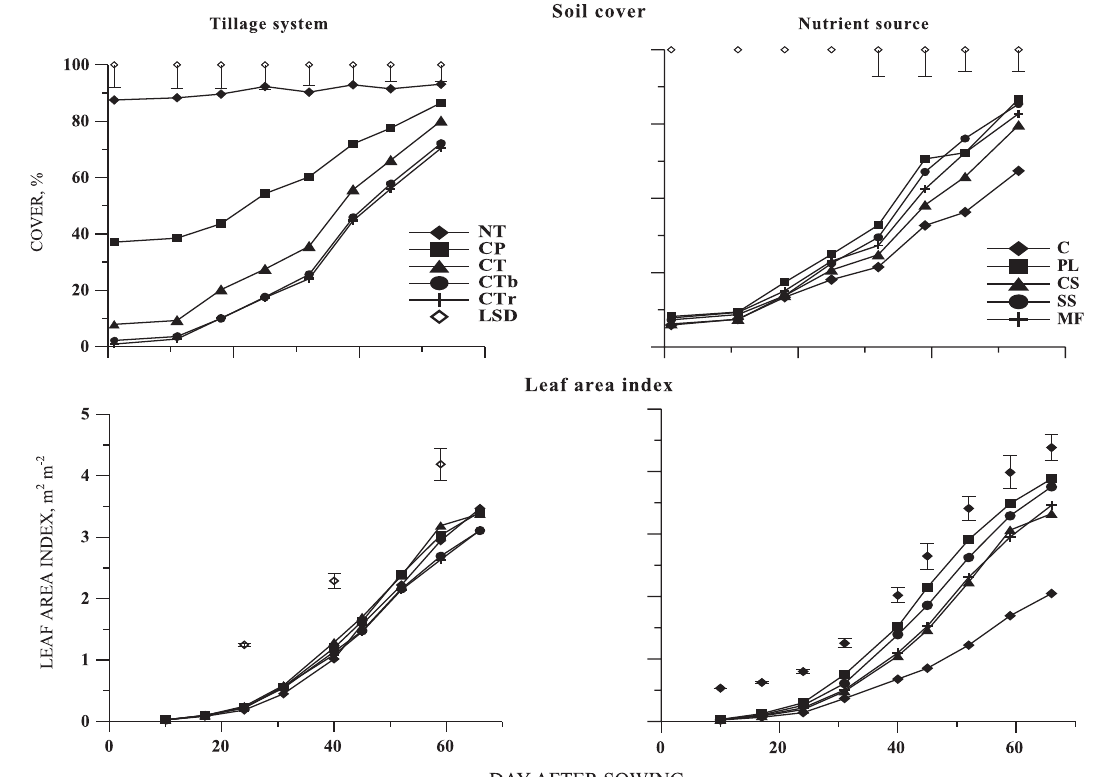
Figure 2. Soil cover by crop residues and corn leaves and leaf area index in the first stage of corn growth in five tillage systems (averaged across nutrient sources) and five nutrient sources (averaged across tillage systems). (NT: no-tillage; CP: chisel plow; CT: conventional tillage; CTb: CT with crop residues burned; CTr: CT with crop residue removed from the field; C: control; PL: poultry litter; CS: cattle slurry; SS: swine slurry; MF: mineral fertilizer; LSD: least significant difference). Vertical bars indicate significant LSD values (Tukey test, p <